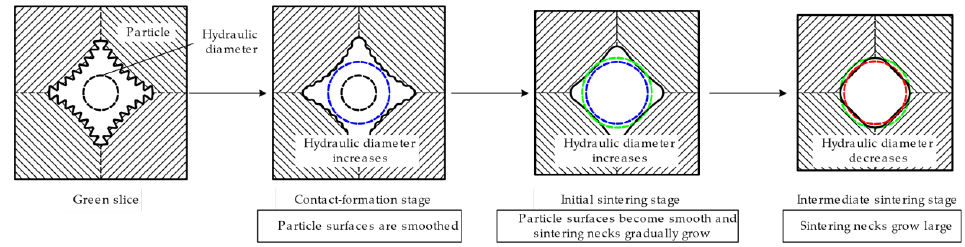
Figure 7. Evolution model of hydraulic diameter in different sintering stages.